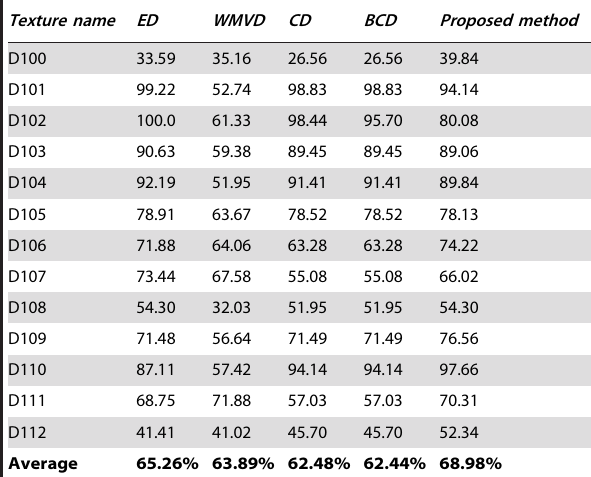
Table 3. Cont. Table 4. Comparison of retrieval performance of different